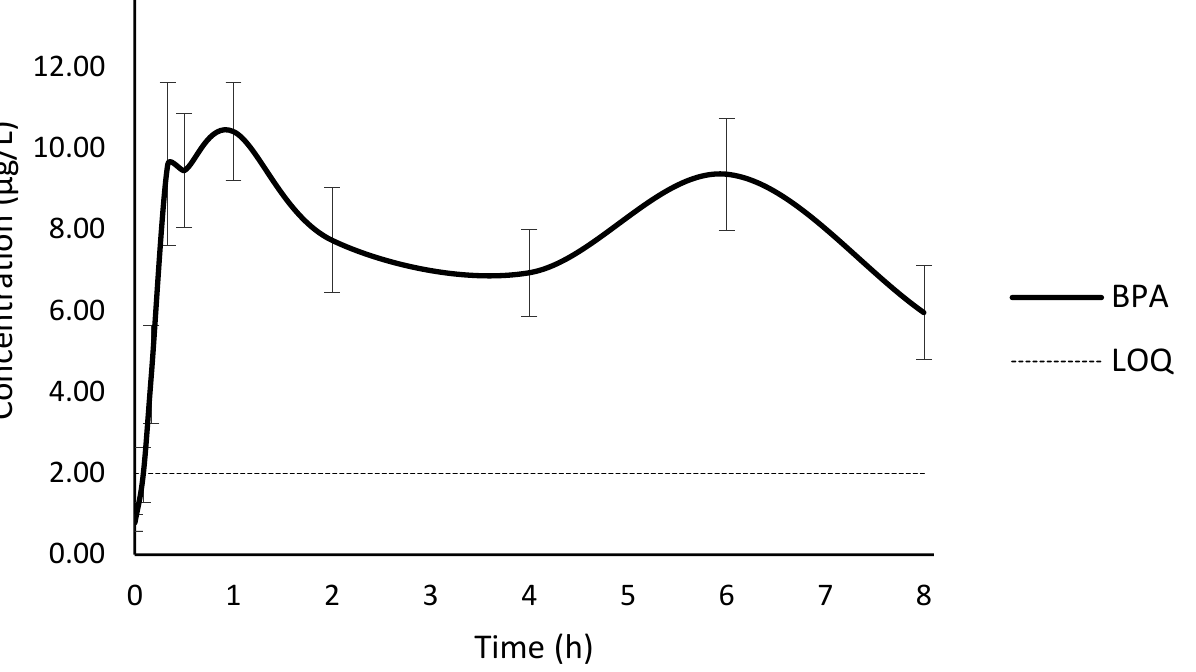
Figure 1. Time course of plasma bisphenol A (BPA) concentration with confidence interval at 95% as error bars and limit quantification (LOQ).